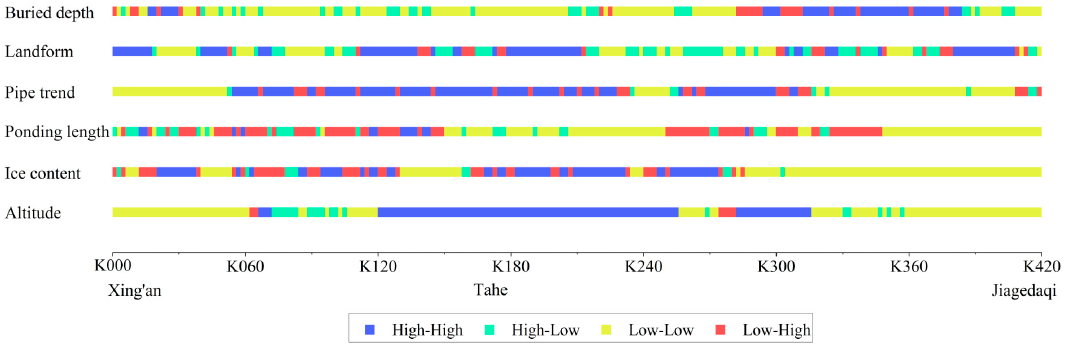
Figure 8. Distributions of the local indicators of spatial association (LISA) aggregations for the six factors (altitude, permafrost type, pond length, pipe orientation, landform type, and buried pipe depth).